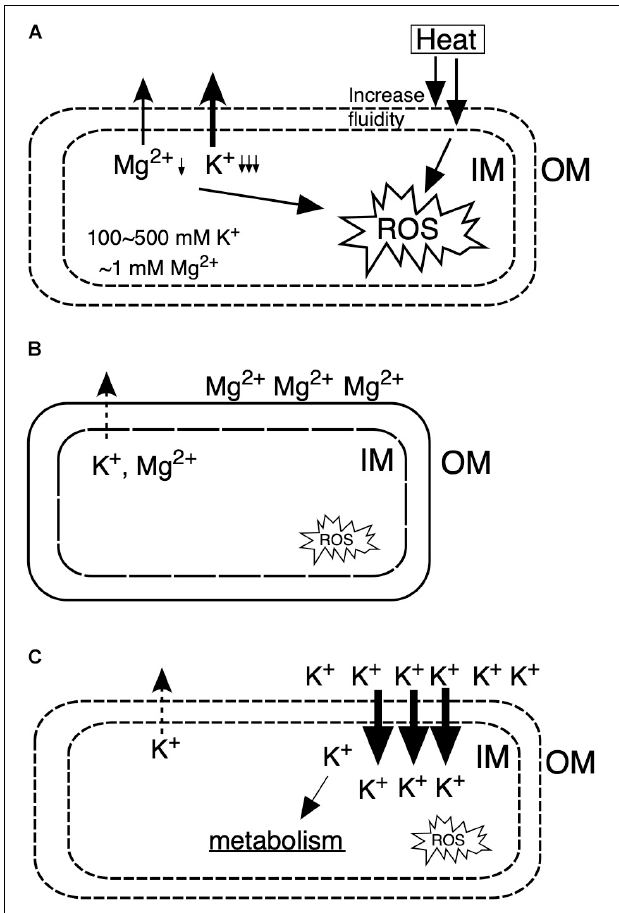
FIGURE 6 | Models for the action mechanisms of Mg 2 + and K + on Z. mobilis TISTR 548 at CHT. (A) Under CHT conditions, (B) by the addition of Mg 2 + , (C) by the addition of K + . IM, inner membrane; OM, outer membrane; ROS, reactive oxygen species.